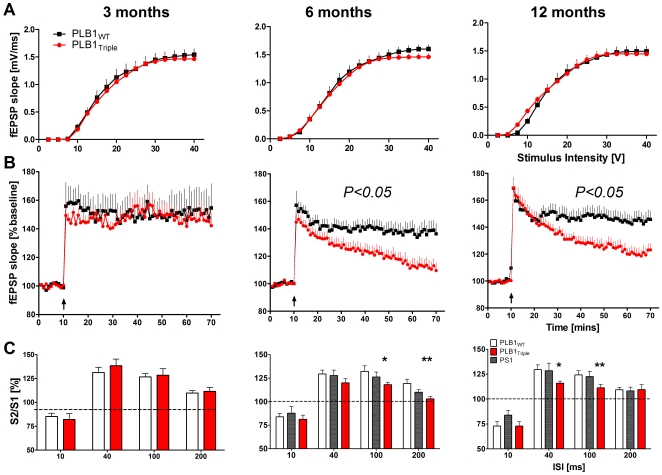
Failure in synaptic plasticity in adult PLB1 mice.Electrophysiological characterisation in the CA1 region of hippocampal slices from PLB1Triple and PLB1WT mice at 3, 6 and 12 months. A: Input-output relationships of basic synaptic transmission (fEPSP slope vs. stimulus intensity; mean+SEM) were not affected in PLB1Triple mice. B: LTP time courses (fEPSP slope as % of baseline, +/− SEM) revealed a significant impairment at 6 and 12 months (genotype effect (P<0.05) and genotype x time interaction (P<0.001)). Arrow: time point of tetanisation. C: Reduced paired-pulse facilitation was uncovered in PLB1Triple mice at 6 and 12 months, but not in PS1 animals and 3-month old PLB1Triple. Data (mean+SEM) are expressed as the slope ratio (S2/S1) vs. inter-stimulus interval (ISI). Significances are indicated as *: P<0.05; **: P<0.01; ***: P<0.001.